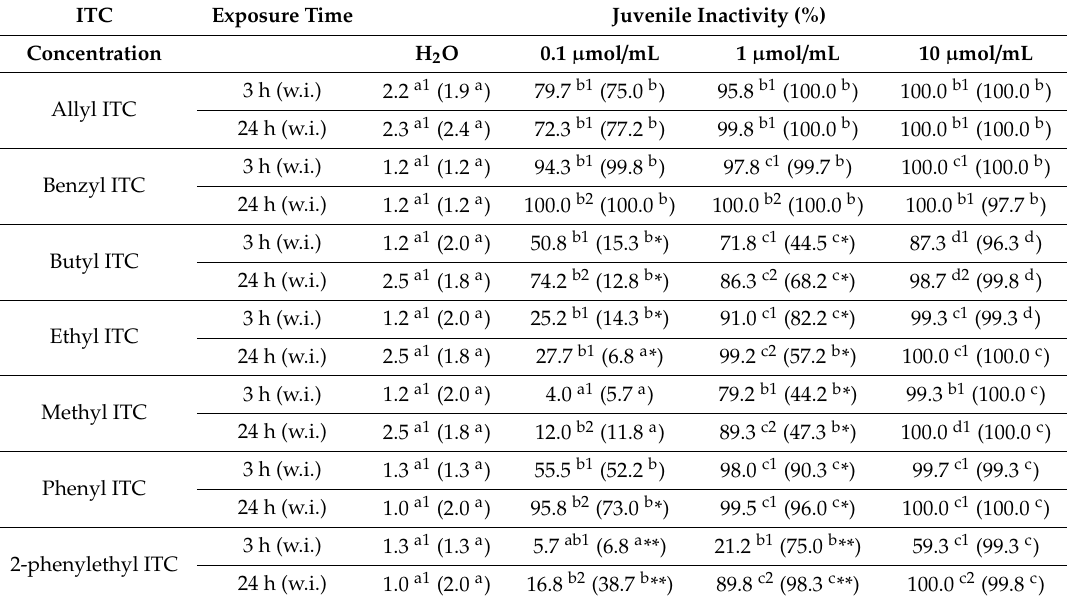
Table 2. E ff ect of di ff erent isothiocyanates at di ff erent concentrations and exposure times on Meloidogyne hapla second-stage juvenile’s motility, with and without recovery in water (w.i.).